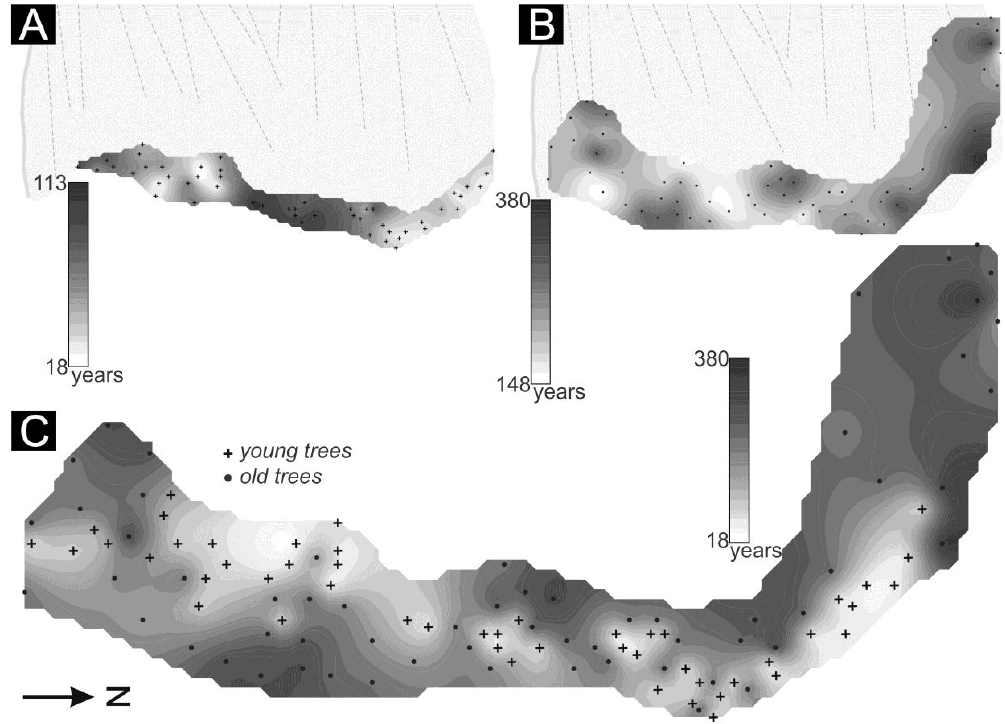
Fig. 4. Spatial distribution of the age structure of sampled trees. A – young trees, B – old trees, and C – all trees.